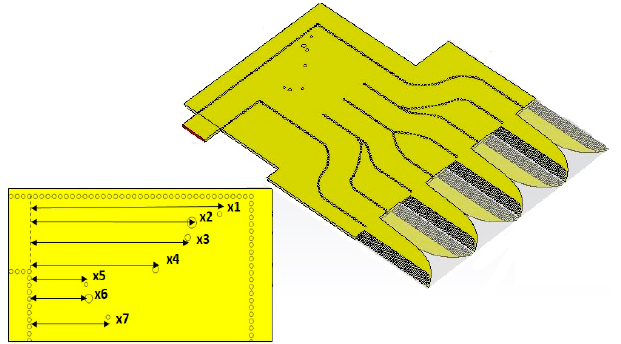
Figure 19. Vivaldi antenna array with four-way SIW power divider structure on Rogers RT6002 with h = 508 mm and ε r = 2.94. The via positions are: x 1 = 18.4 mm, x 2 = 15.8 mm, x 3 = 15.4 mm, x 4 = 12.2 mm, x 5 = 5.52 mm, x 6 = 5.78 mm, x 7 = 7.64